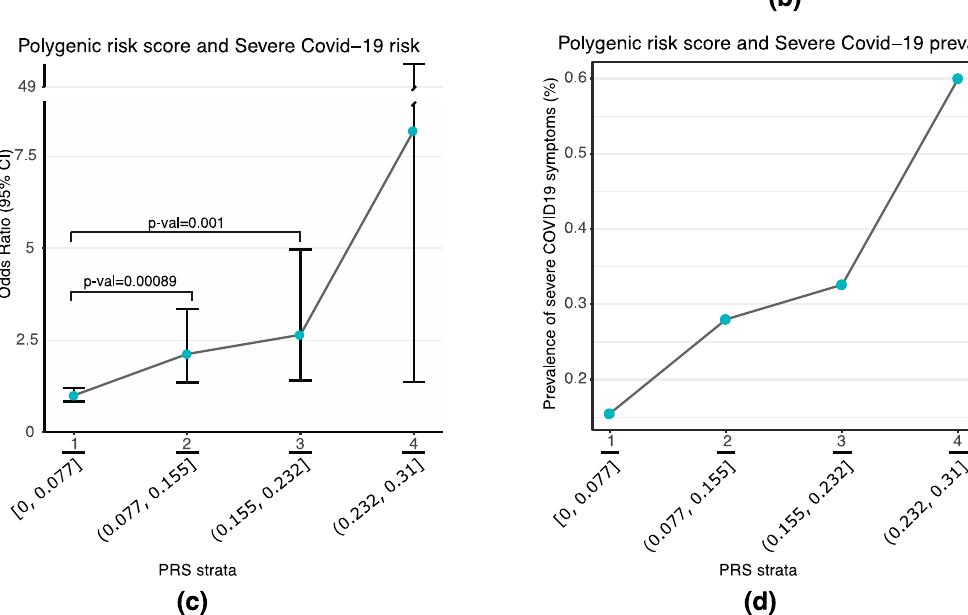
Figure 2. Distribution of the PRS in cases and controls and severe COVID-19 risk in the Italian population. ( a ) Comparison of PRS scores between cases and controls. In the boxplot, boxes define the interquartile range; thick lines refer to the median. Samples were divided into 4 strata (dividing the entire range of PRS values into 4 evenly spaced intervals). Dotted grey lines represent boundaries between each PRS stratum. The p value was calculated using the Wilcoxon rank sum test. ( b ) Proportion of cases and controls in each PRS stratum (setting as 100% the overall amount of individuals for each stratum). ( c ) Risk of severe COVID-19, expressed as OR ± 95%CI by strata. ORs were calculated comparing the lowest stratum as reference against all the others. p -values from Chi-square test are reported for 2nd and 3rd PRS strata (not indicated for highest stratum due to lower number of individuals). ( d ) Percentage of case samples within each PRS stratum (with 100% as the total number of cases and controls populating that stratum). All plots were produced using R.